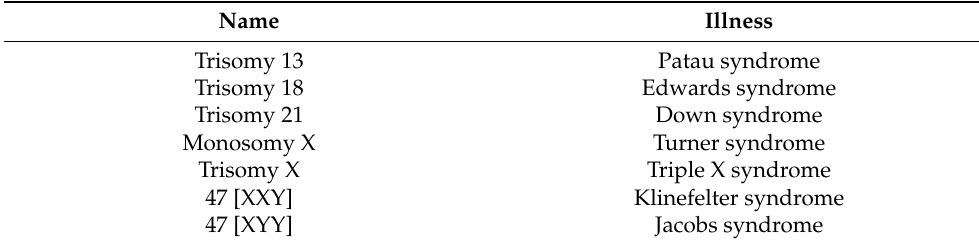
Table 1. Common chromosomal